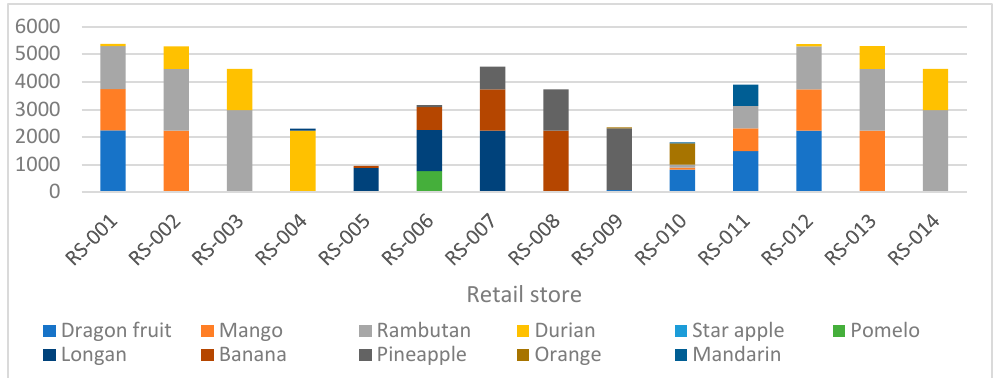
Figure 10. Early and delay time at retail stores (hour).